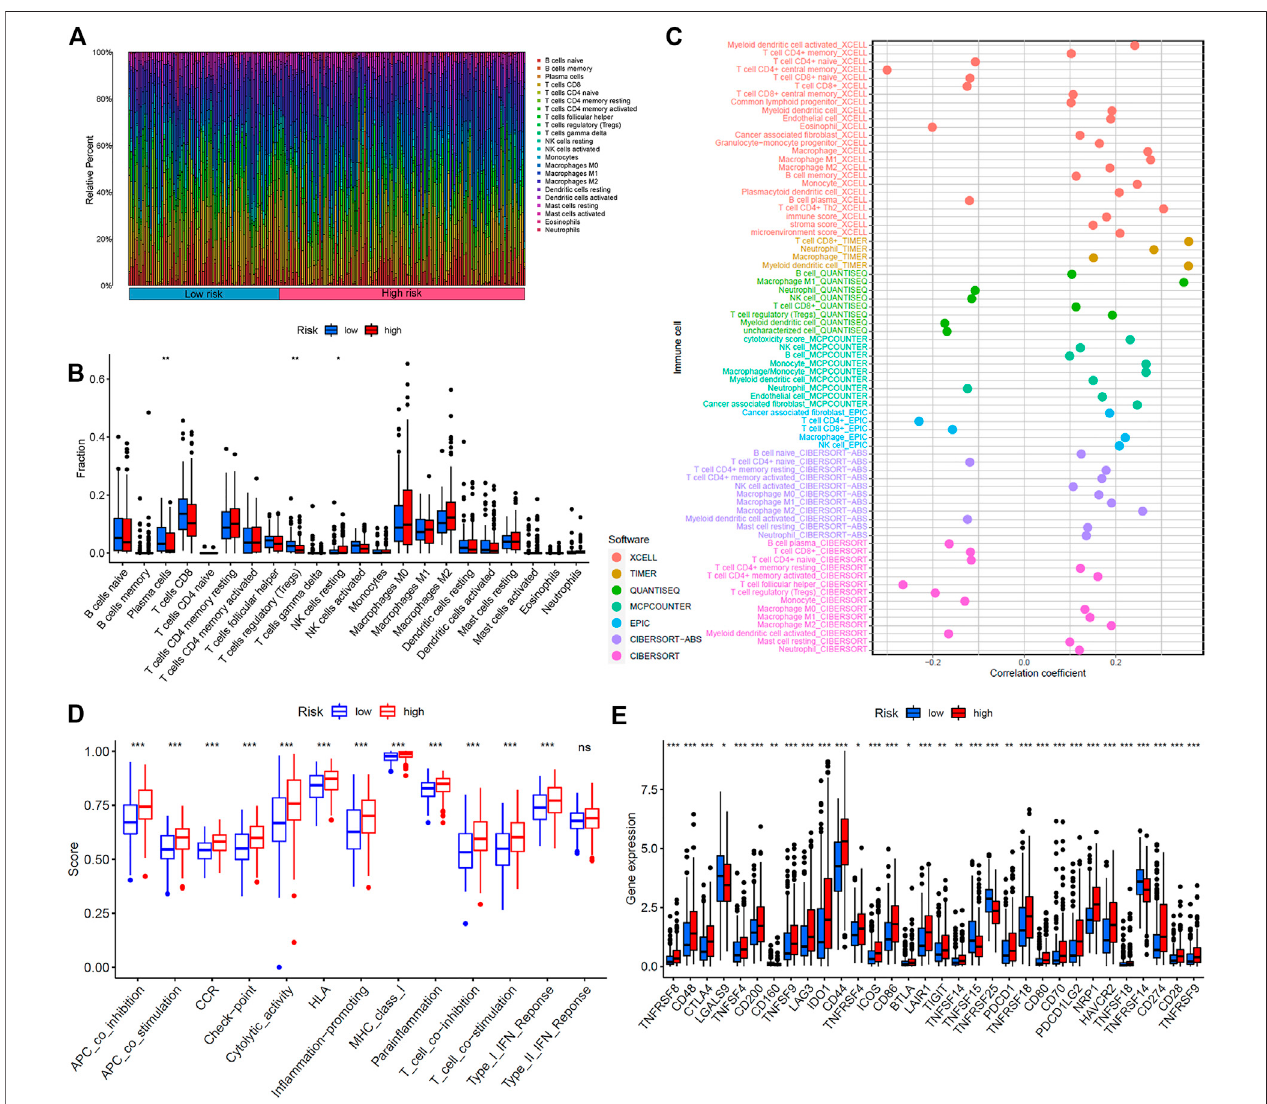
FIGURE 7 | Immunoassay showed that the fi ve ferroptosis-prognosis – related lncRNAs were closely related to the immune system. (A) Proportion ofimmune cells in the high- and low-risk groups. (B) Immune cell abundance in the high- and low-risk groups. (C) Correlation analysis between immune cell abundance and the risk score. (D) Immune function analysis showed that there were signi fi cant differences between the high- and low-risk groups. (E) Comparison of immune checkpoints between two risk groups.